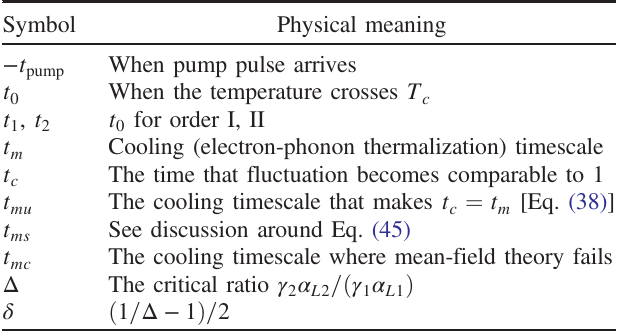
TABLE I. Physical meaning of various timescales and Δ